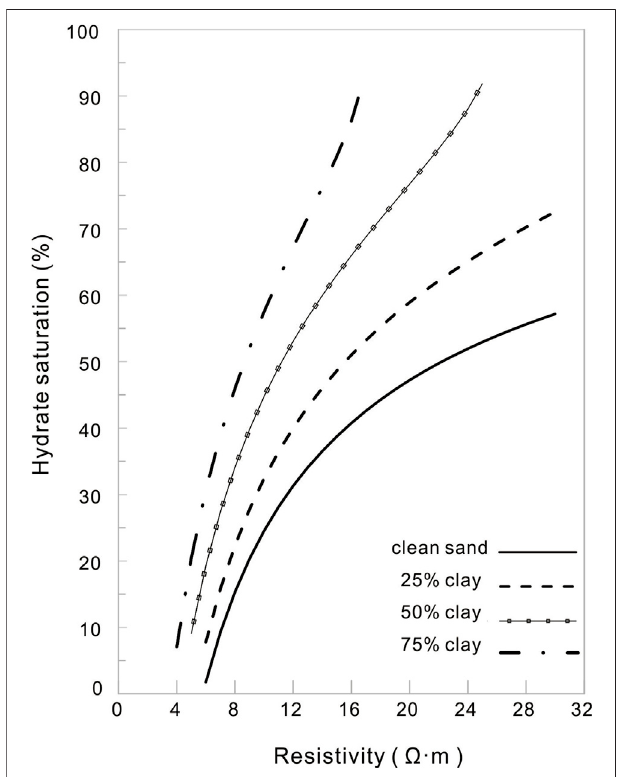
FIGURE 3 | The curve of the hydrate saturation varying in depth is suitable for natural gas hydrate reservoirs with various clay content.